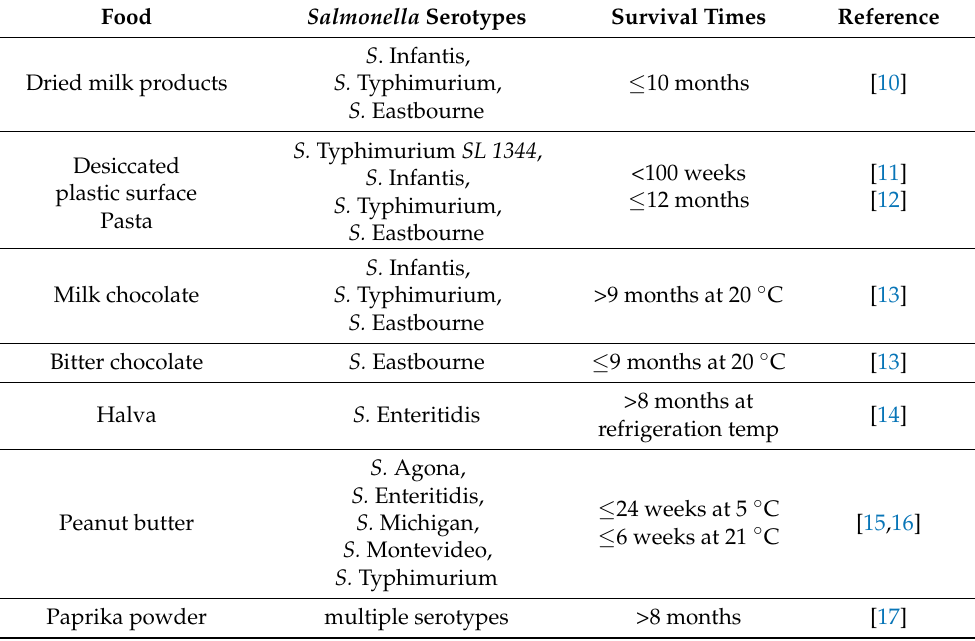
Table 1. Salmonella survival times in low water activity